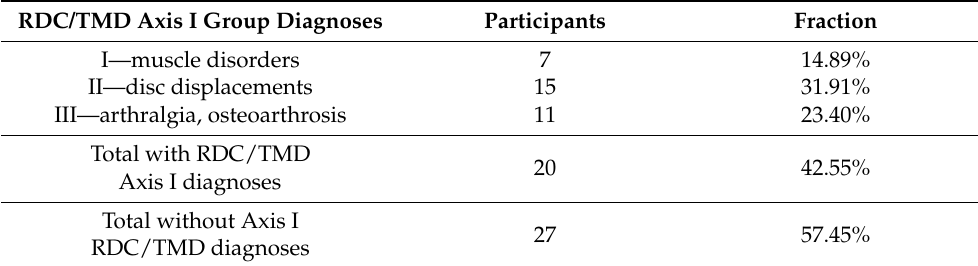
Table 1. RDC/TMD Axis I diagnosis in the examined group of a total of 47